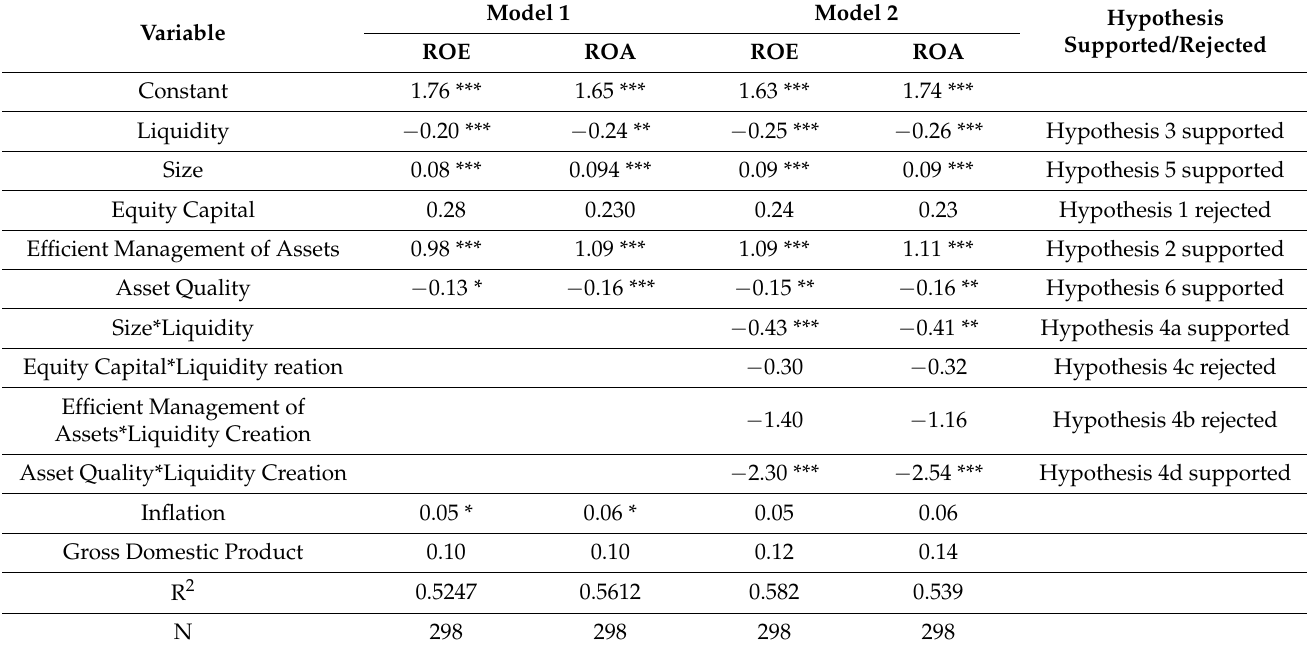
Table 2. Results of ordinary least squares regressions of return on equity and return on assets on main and moderated independent